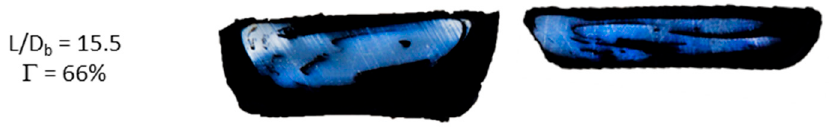
Figure 14. Cross section of polymer ribbon of both channels extracted at an axial position of 15.5 L / D b during a solidification experiment with barrel 1 and screw 1. The white and black sections indicate solids and polymer melt, respectively.